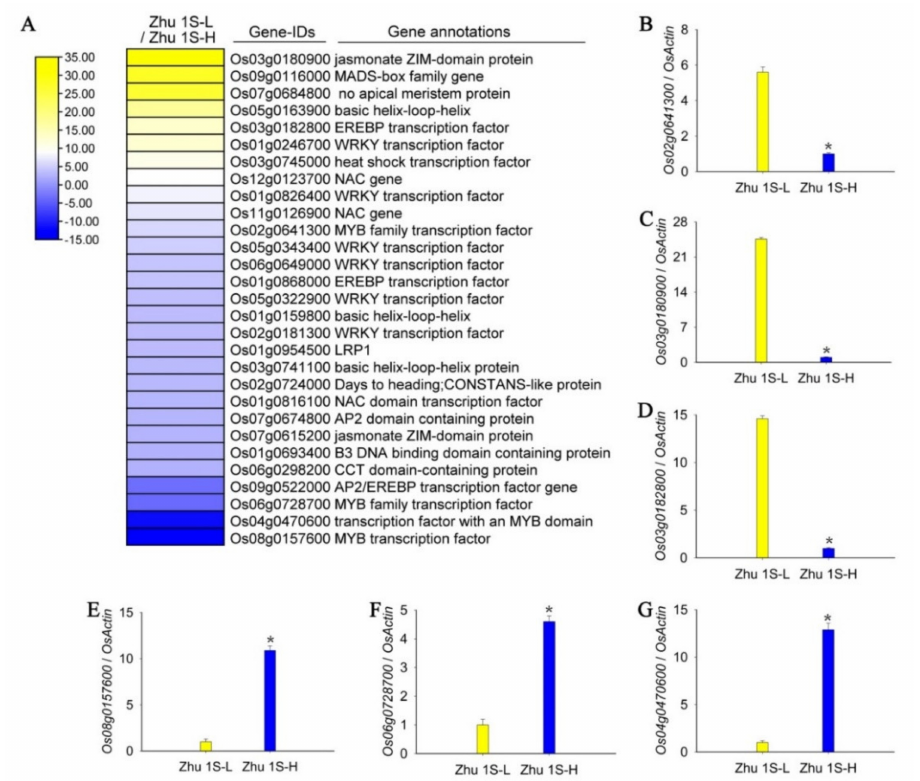
Figure 4. Differentially expressed genes involved intranscription factor in Zhu 1S under high temperature. ( A ) Heatmap representation of differentially expressed genes in Zhu 1S under high temperature. The yellow and blue colors represent up–regulation and down-regulation of genes involved in the transcription factor in Zhu 1S under high temperature, respectively. ( B – G ) The relative expressions of six representative genes were validated by real-time PCR. OsActin1 as an internal control. The experiment was repeated three times with similar results. Data are means of five replicates of one experiment. Asterisks represent significant differences. Error bars represent ±